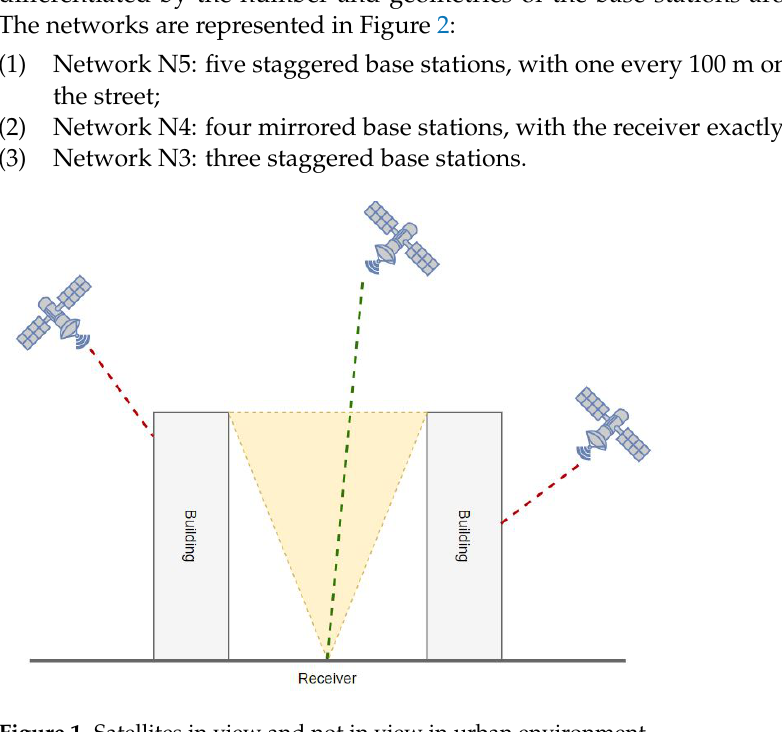
Figure 1. Satellites in view and not in view in urban environment.